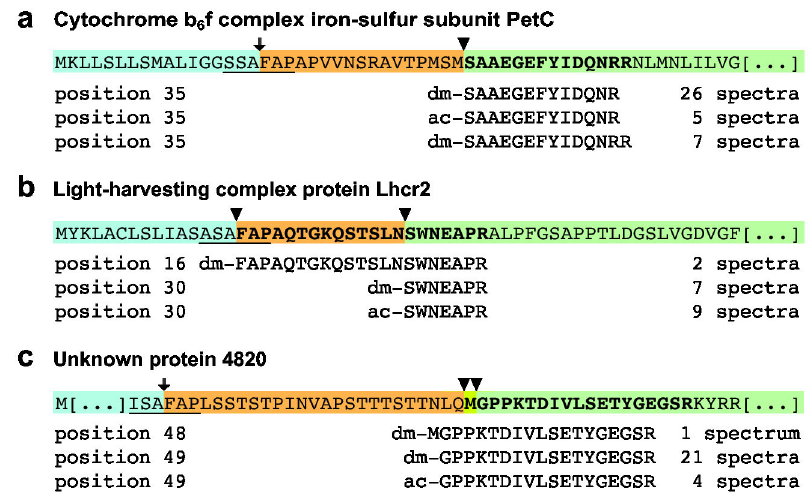
Figure 3. Approach for determining diatom transit peptide sequences. Transit peptides (orange) and transit peptide cleavage sites were deduced by mapping identified N termini (green) to the protein model sequence after removal of the ER signal sequence (blue). (a) Cytochrome b f complex iron-sulfur protein subunit (PetC). Three peptides identify a single unique N terminus at position 6 35 of the protein model. (b) Light harvesting antenna complex protein Lhcr2. An acetylated and a dimethylated peptide identify the mature protein N terminus at protein model position 30, and a dimethylated peptide begins at the canonical SP cleavage site (ASA- FAP) at protein model position 16, indicating that this protein was incompletely processed or in transit when isolated. (c) Unknown protein 4820, homologous to a putative higher plant plastid precursor protein. Two peptides identify a mature, partially acetylated N terminus starting at protein model position 49, while a third peptide has an N-terminal Met starting at position 48. Bold, observed peptides; underlined, conserved ASA-FAP motif; arrow, inferred ER signal peptide cleavage site; arrowhead, observed protein termini. doi: